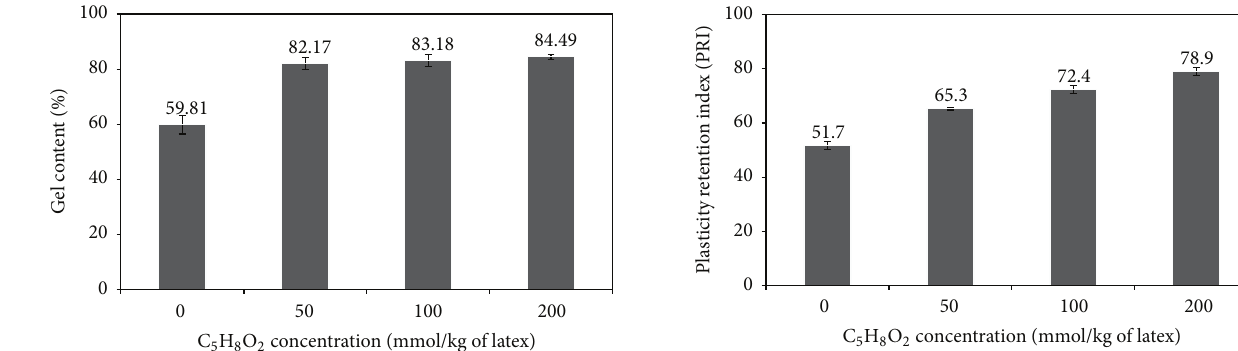
Figure 4: Gel content in NR obtained from the fresh NR latex treated with different concentrations of C 5 H 8 O 2 .